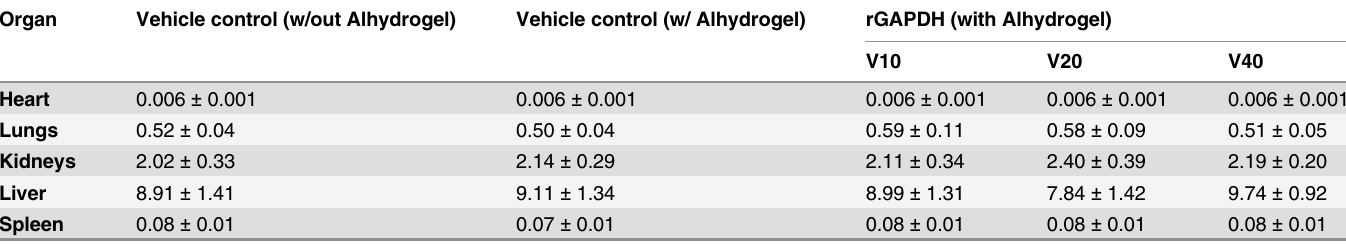
Values are expressed as mean ± S.D; Number of animals per goup = 6; V10 — 10 μ g s.c.; V20 — 20 μ g s.c.: V40 — 40 μ g s.c. One-way ANOVA with post- hoc Dunnett's Multiple Comparison Test, p > 0.05.